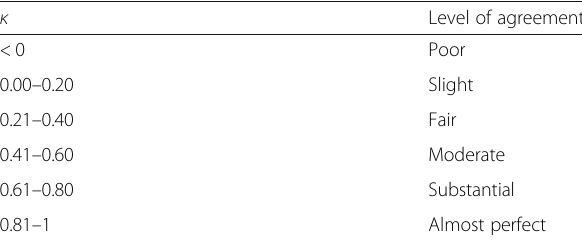
Table 2 Determination of interpretation categories of kappa values, adapted from Landis and Koch [10]